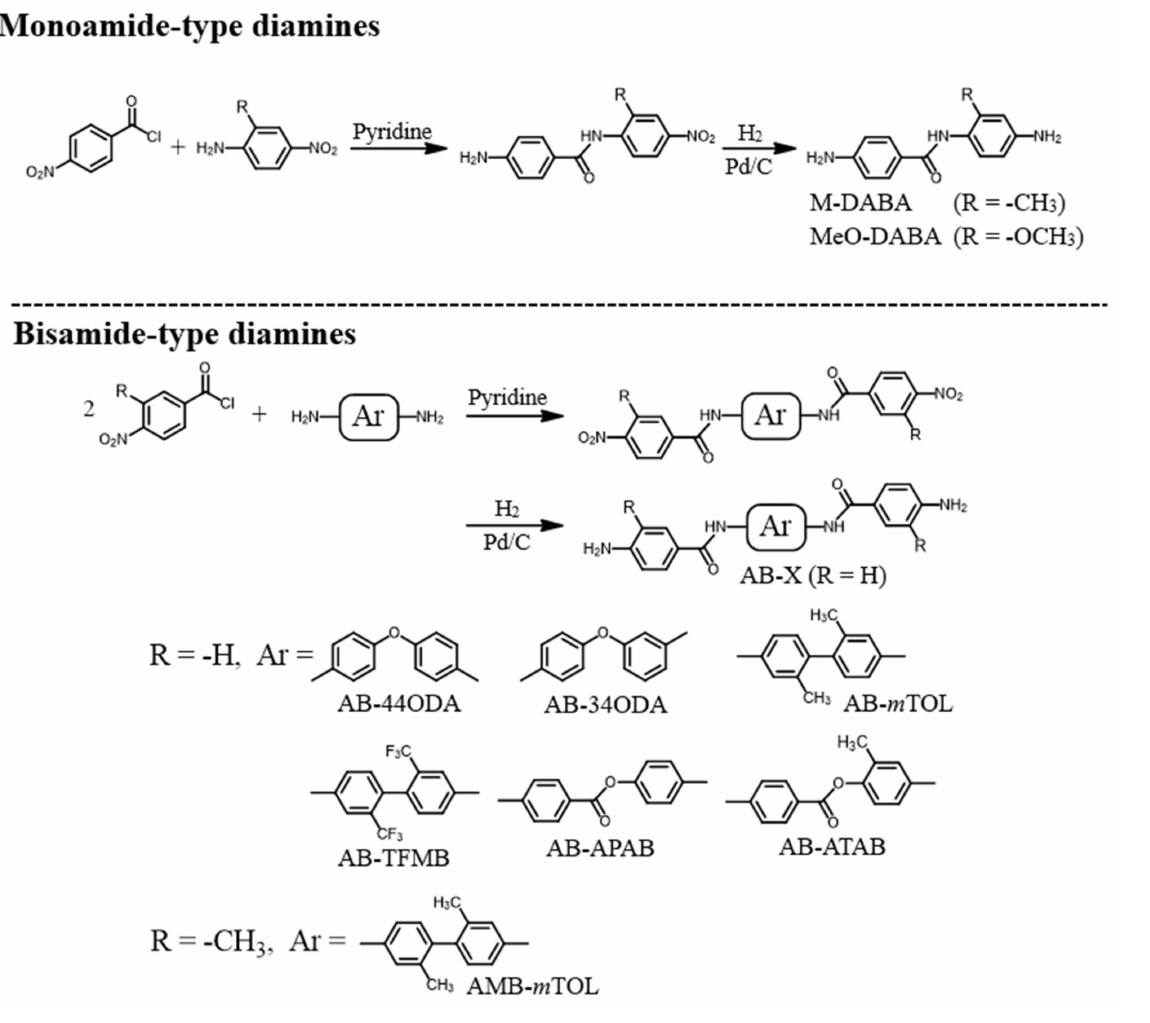
Figure 1. Reaction schemes for the synthesis of monoamide- and bisamide-type diamines. AB-44ODA: In a sealed flask, 4,4 (cid:48) -oxydianiline (4,4 (cid:48) -ODA, 15 mmol) was